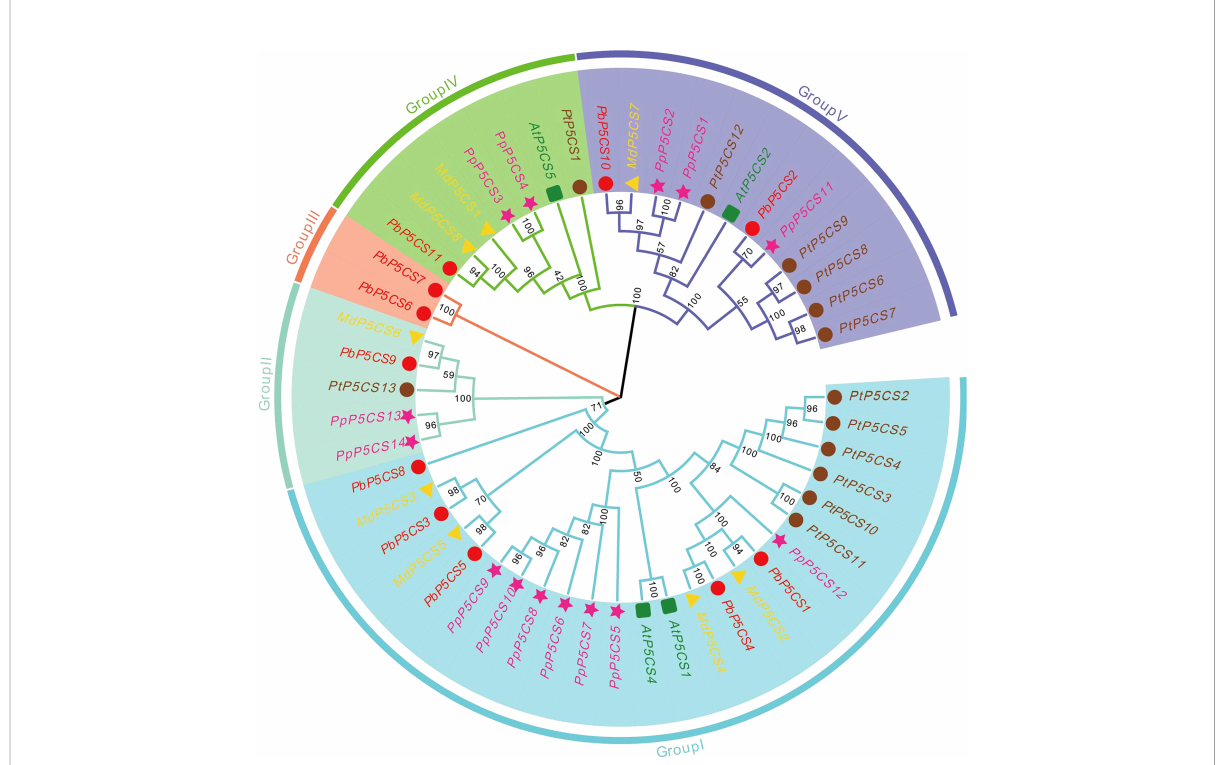
FIGURE 1 Phylogenetic tree of P5CS proteins constructed using the neighbor-joining method with P5CS domains from pear Pyrus betulifolia (red circles), Malus domestica (yellow triangles), Populus trichocarpa (pink pentagons), Prunus persica (brown circles), and Arabidopsis thaliana (green squares). Members are divided into Groups I, II, III, IV, and